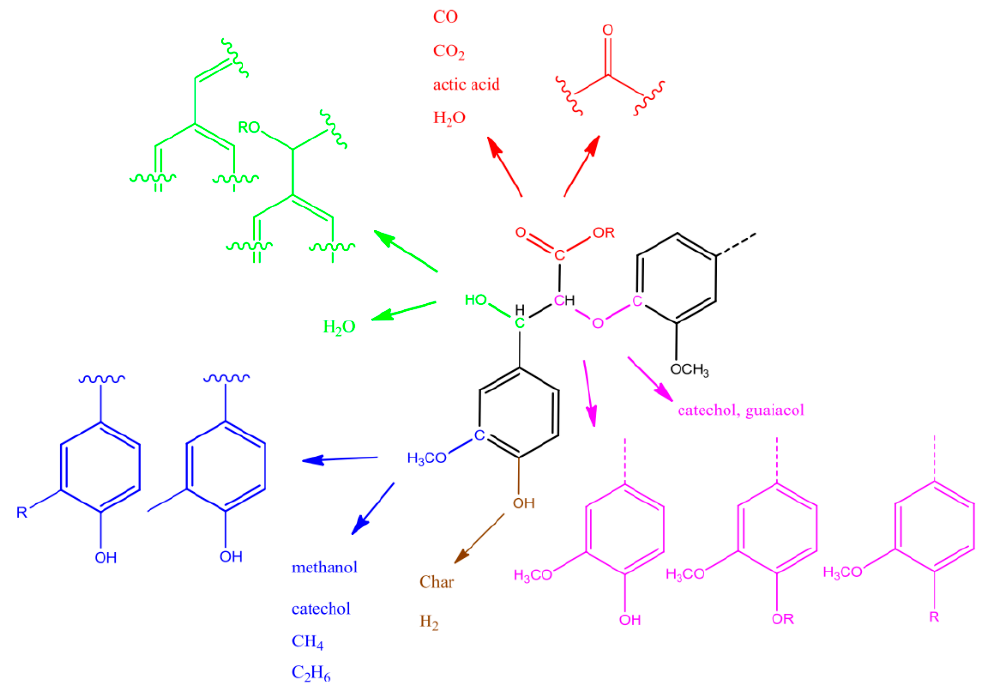
Figure 1. The possible decomposition pathways of lignin during the pyrolysis [8] .